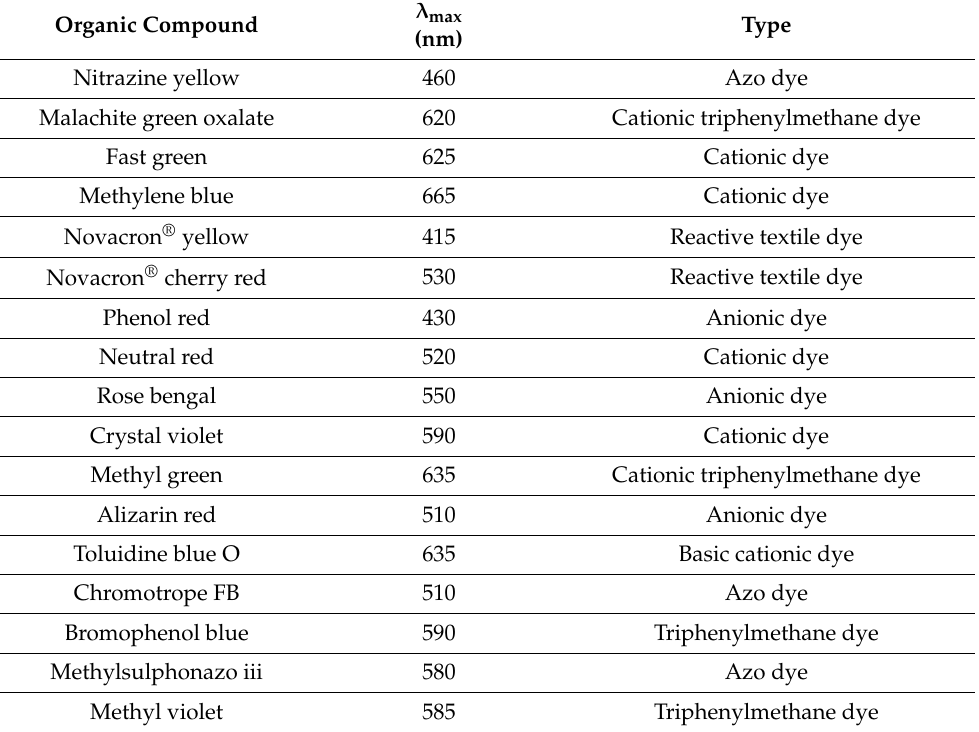
Table 1. Properties of the selected